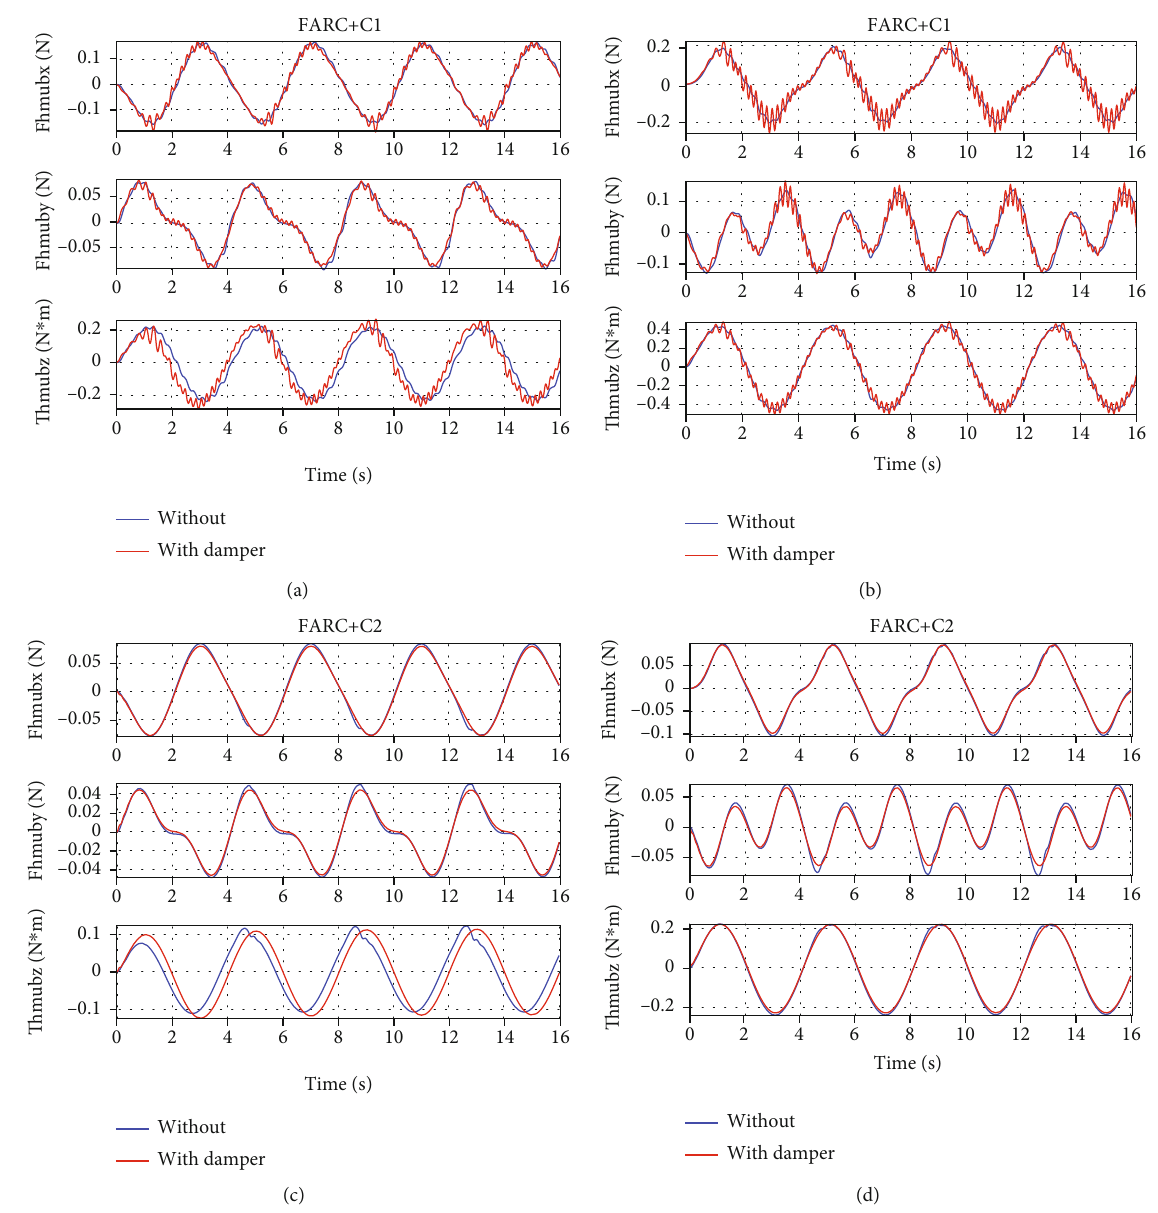
Figure 11: Simulation results of left leg support for Set4: (a) human-machine interaction force at the back for FARC+C1, (b) human- machine interaction force at the right foot for FARC+C2, (c) human-machine interaction force at the back for FARC+C2, and (d) human-machine interaction force at the right foot for